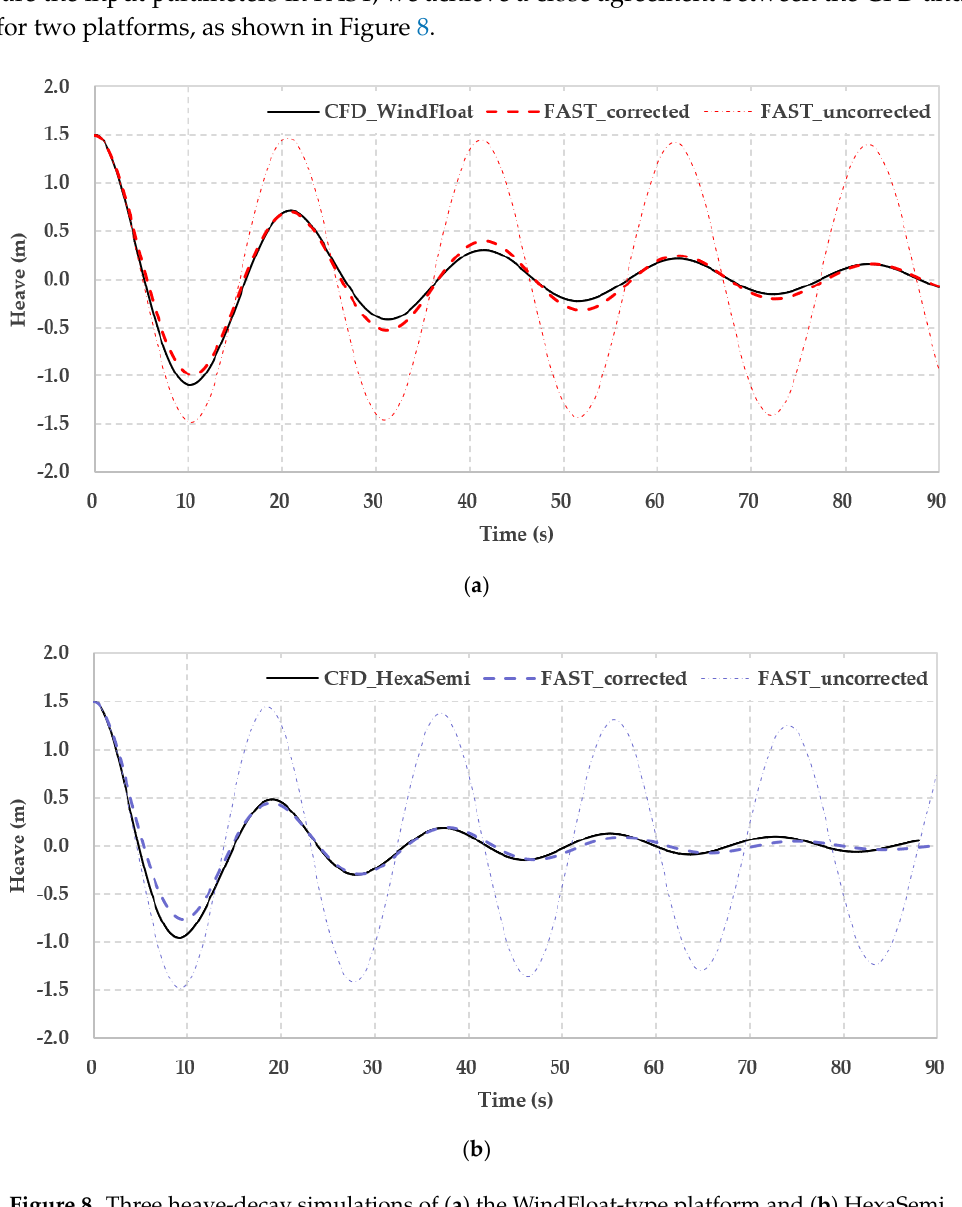
Figure 8. Three heave-decay simulations of ( a ) the WindFloat-type platform and ( b ) HexaSemi